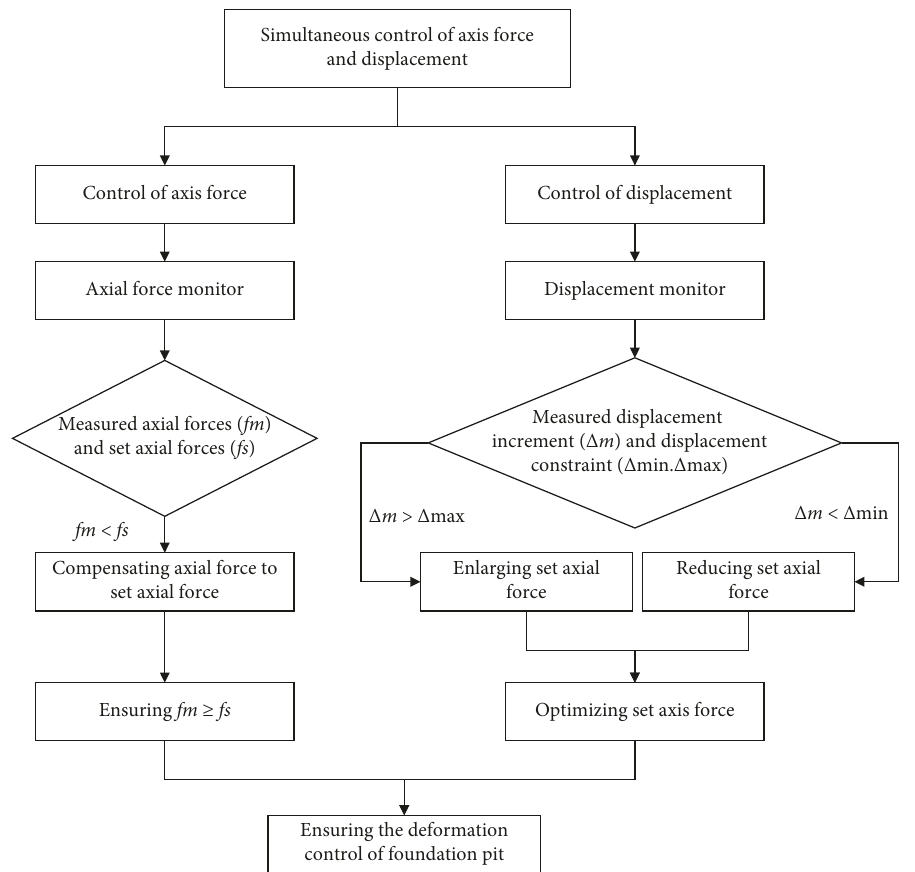
Figure 6: Working mechanism of the hydraulic servo steel strut